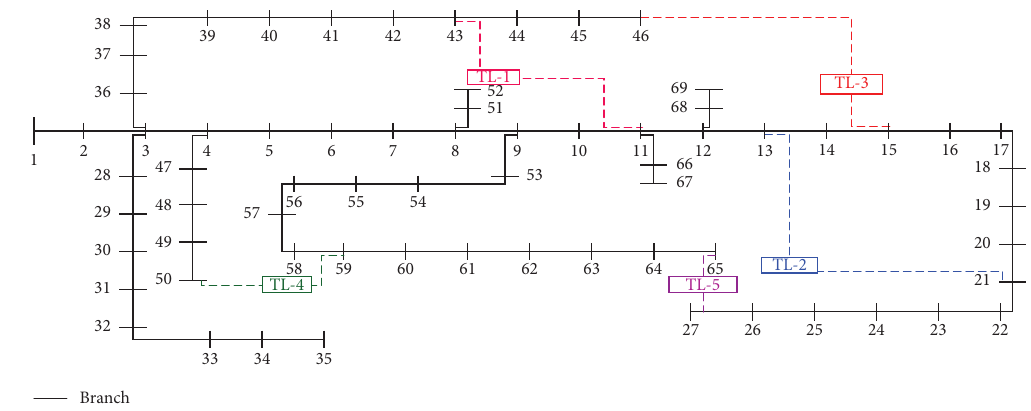
Figure 5: Sixty nine-bus weakly meshed distribution